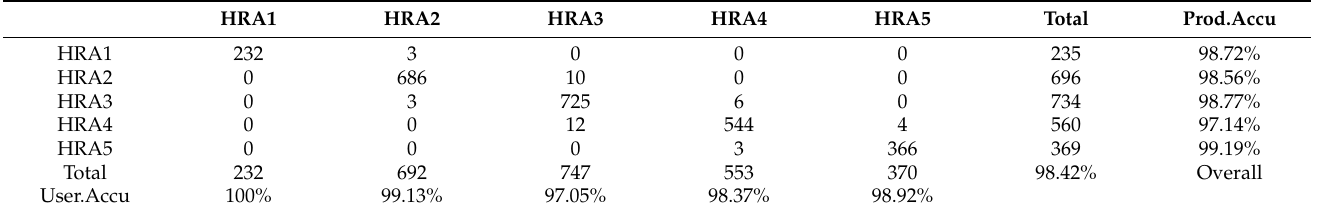
Table 3. Confusion matrix of the validation dataset in “Selva El Ocote.” Prod.Accu = Producer Accuracy and User.Accu = User